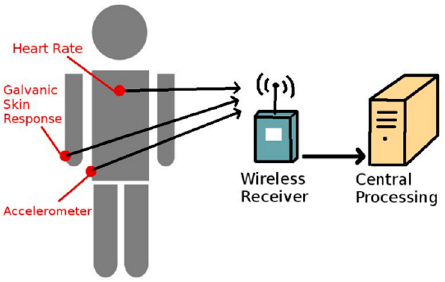
Figure 1. A theoretical Body Area Sensor Network (BASN) .